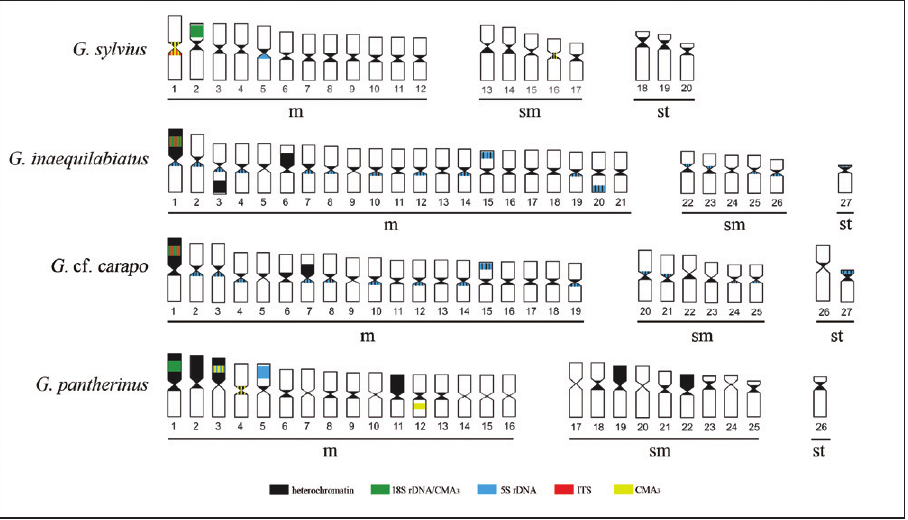
Figure 7a–d. Ideogram showing the hybridization patterns described in this paper. The overlapping signals are represented simultaneously by the respective colors ( a ) G . sylvius , ( b ) G . inaequilabiatus , ( c ) G . cf. carapo and ( d ) G . pantherinus